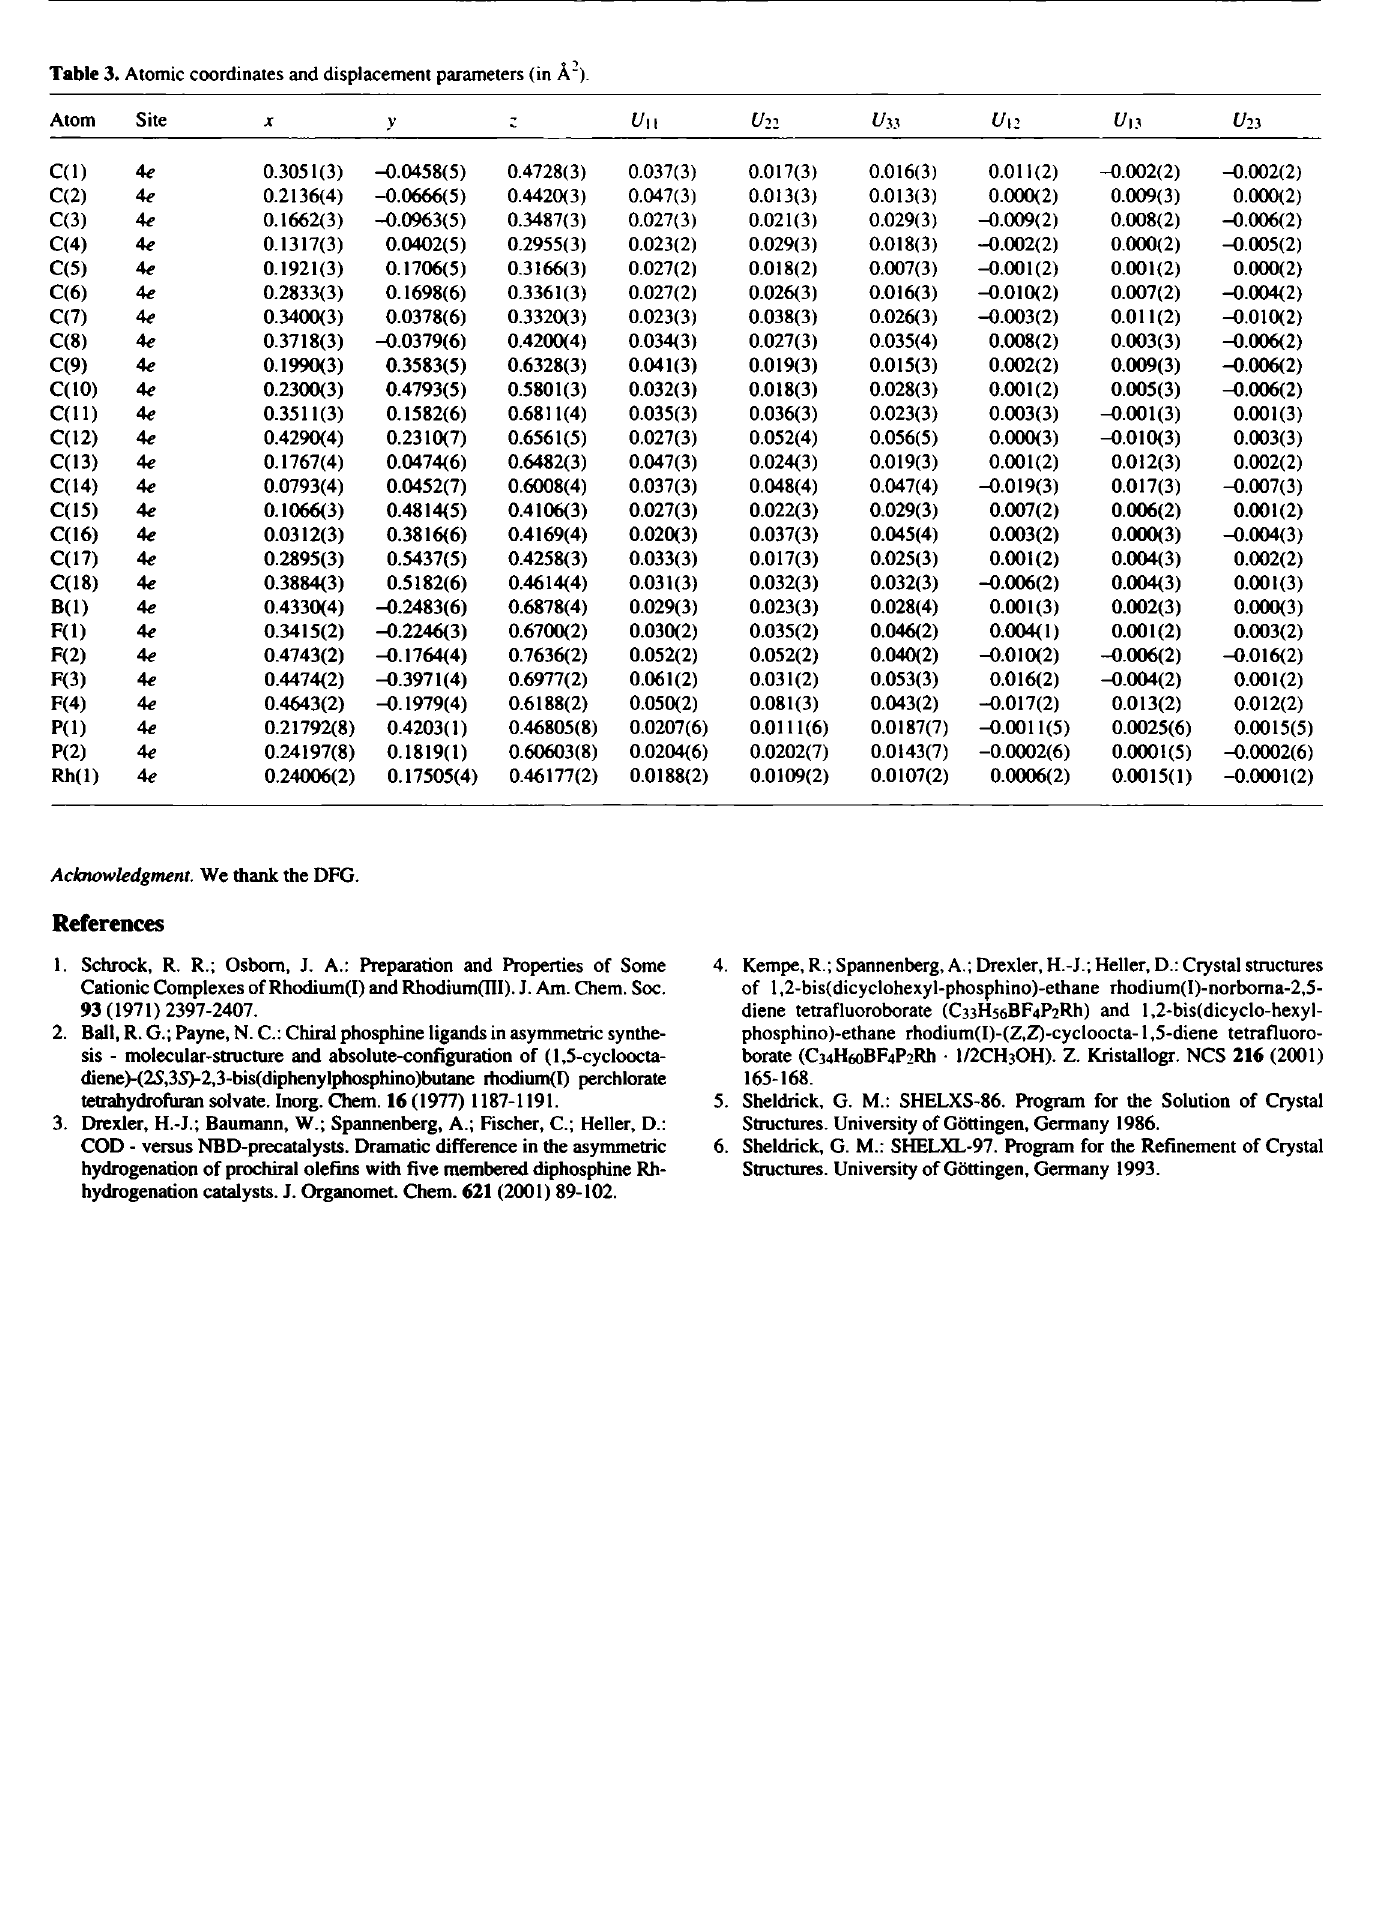
Table 3. Atomic coordinates and displacement parameters (in Â 2 ). Atom